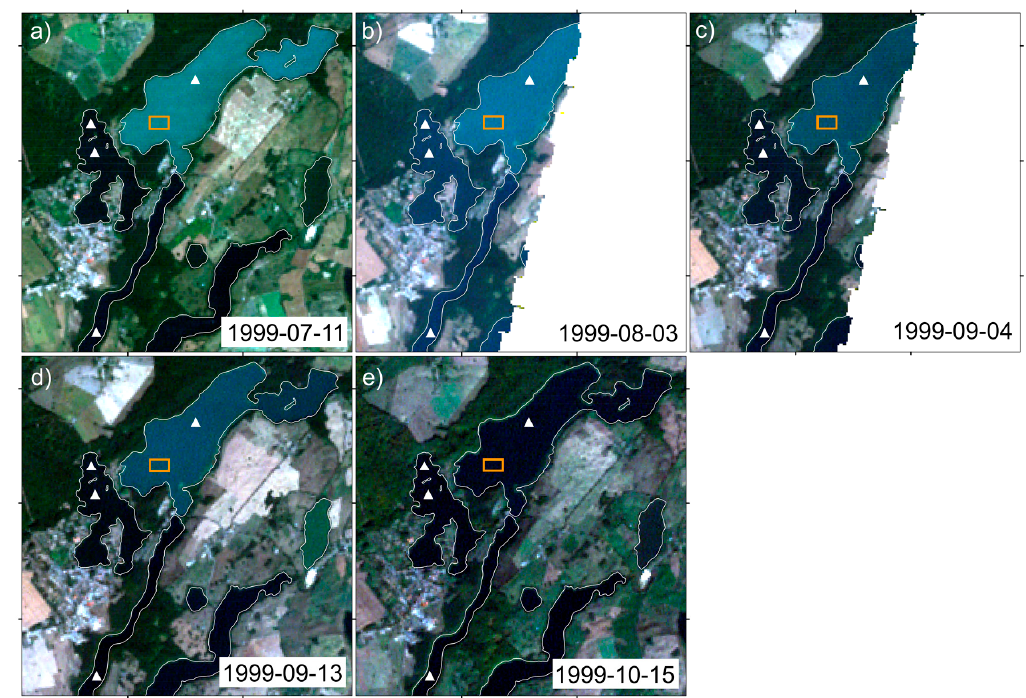
Figure 9. Quasi ‐ true color RGB Landsat 7 images of the Feldberg Lake District. The extent is the same as in Figure 2. All lakes are framed with lines and the positions of in situ measurements are marked with white triangles. The orange rectangle shows the ROI that was used for the extraction of the reflectance spectra. BL is turquoise colored on 11 July 1999 ( a ) due to calcite precipitation. In the following, calcite precipitation diminishes from 3 August 1999 to 13 September 1999 ( b – d ), and on 15 October 1999 ( e ) BL appears dark again.